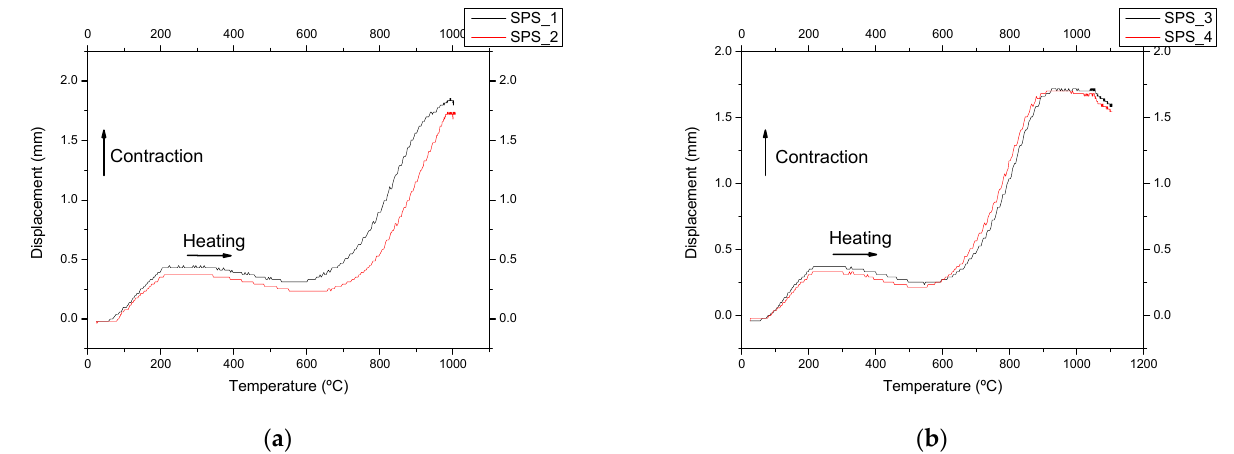
Figure 4. Vertical displacement evolution for ( a ) SPS_1 and SPS_2 and ( b ) SPS_3 and SPS_4 sintering cycles. From Figure 5, the microstructure of the samples sintered at 1000 and at 1100 °C can be observed. Samples sintered at higher temperature present higher densification than samples sintered at 1000 °C. The samples sintered at 1000 °C (Figure 5a,b) reveal a lower densification due to the porosity close to some rounded-shape particles which correspond with the initial powder particles. Confirmation that the densification process has not been completed is recorded in the displacement versus temperature curve (Figure 4a). How- ever, the study of the microstructure of these samples sintered at 1000 °C could help to understand the sintering behaviour of the alloy. By increasing the sintering temperature and improving densification, a refinement of the microstructure and a reduction in poros- ity are observed. All the samples show the presence of two main phases: a grey matrix and a brighter elongated and crisscrossed phase. Moreover, the microstructures present a third bright phase in the grain boundaries which could correspond with Cu segregation as has been observed in the atomised powder in Figure 3.